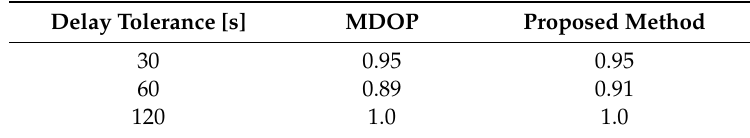
Table 8. Ratio of data sent by delay